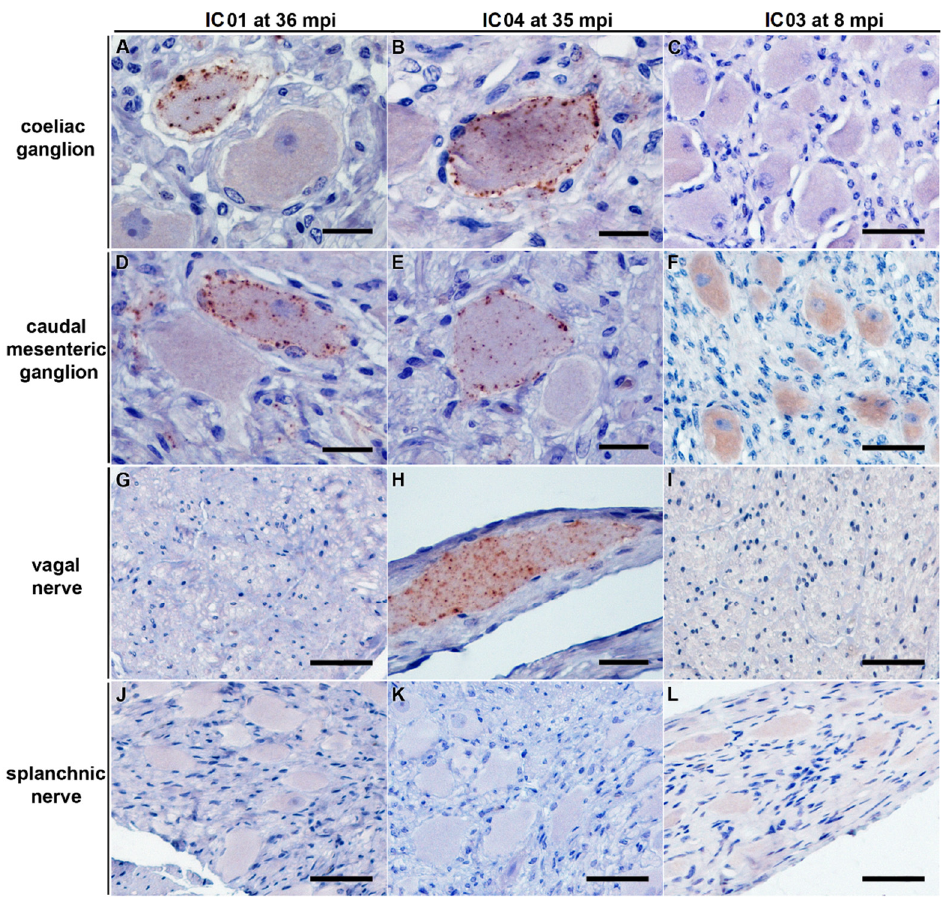
Figure 4. PrP BSE accumulation in the coeliac and caudal mesenteric ganglion as well as the vagal nerve of positive control cattle. IHC results obtained for positive controls IC 01 (36 mpi; ( A , D , G , J )) and IC 04 (35 mpi; ( B , E , H , K )) as well as preclinical calf IC 03 (8 mpi; ( C , F , I , L )); ( A , B , D , E ): fine to coarse granular intracytoplasmatic as well as perineuronal PrP BSE accumulation in a ganglia cell of the coeliac ganglion ( A , B ) and the caudal mesenteric ganglion ( D , E ) of IC 01 (36 mpi; ( A , D )) and IC 04 (35 mpi; ( B , E )); H: intracytoplasmatic fine to coarse granular accumulation of PrP BSE in a ganglia cell contained in the vagal nerve of IC 04 (35 mpi); ( C , F , G , I – L ): no staining reaction in samples from nervous tissues of calf IC 03 (8 mpi; ( C , F , I , L )) as well as vagal nerve of IC 01 ( G ) and splanchnic nerves of IC 01 ( J ) and 04 ( K ), while the diffuse staining reaction in neural cells in the caudal mesenteric ganglion of IC 03 ( F ) represents an nonspecific background staining; ( A – L ): Immunohistochemistry, PrP mAb 6C2; ( A , B , D , E , H ): bar 20 µm; ( C , F , G , I – L ): bar 50 µm.